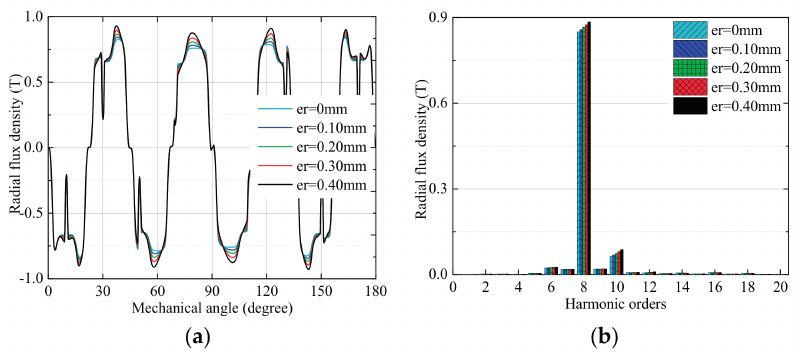
Figure 10. Analysis of the radial component of magnetic flux density in the IPMSM with rotor deformation at no-load condition. ( a ) Distribution curves; ( b ) Harmonic contents.